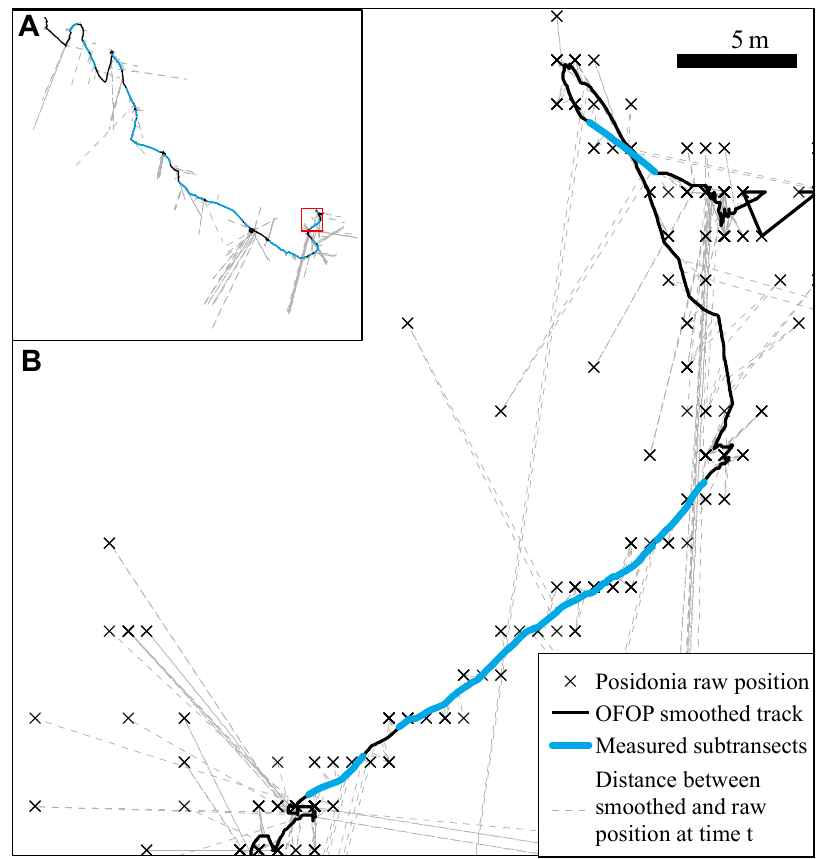
Fig. 7. (A) Overview showing the extent (red rectangle) of (B) high resolution detail of the ROV track during dive B (projection Lambert azimuthal equal area) highlighting the distance between the raw ROV positions from Posidonia and the OFOP smoothed